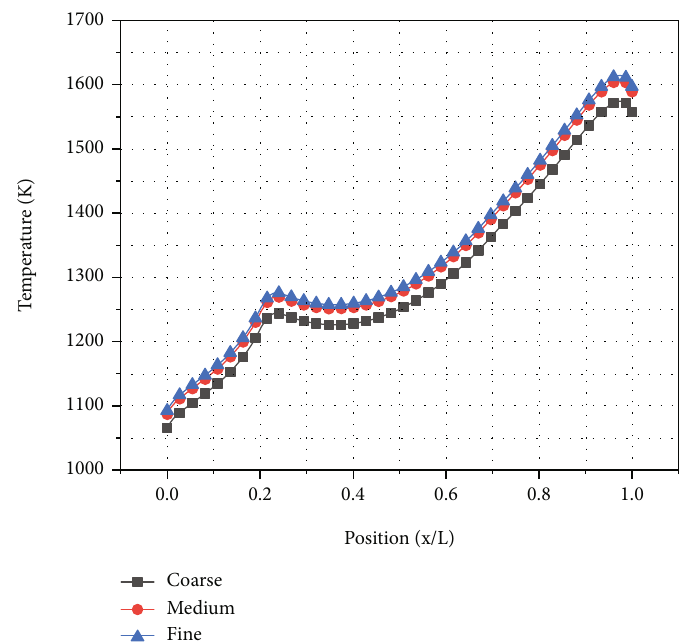
Figure 9: Comparison of temperature for three di ff erent mesh densities to test the mesh independence.